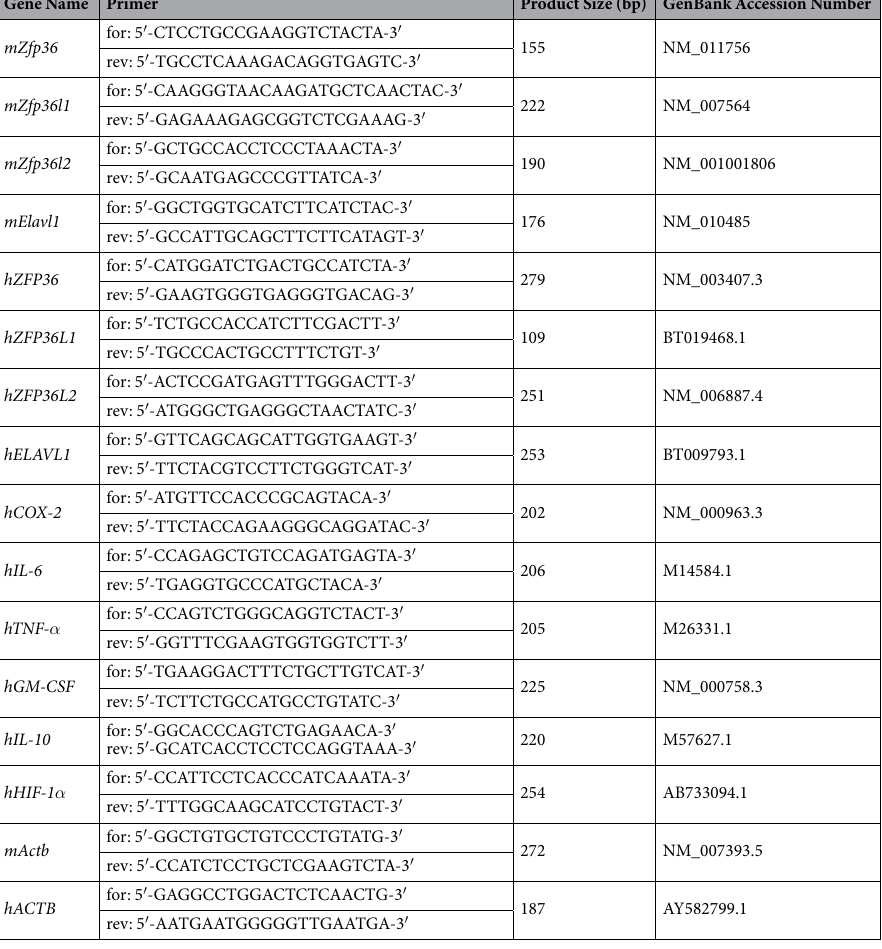
Table 1. mRNAs Assessed by Real-Time